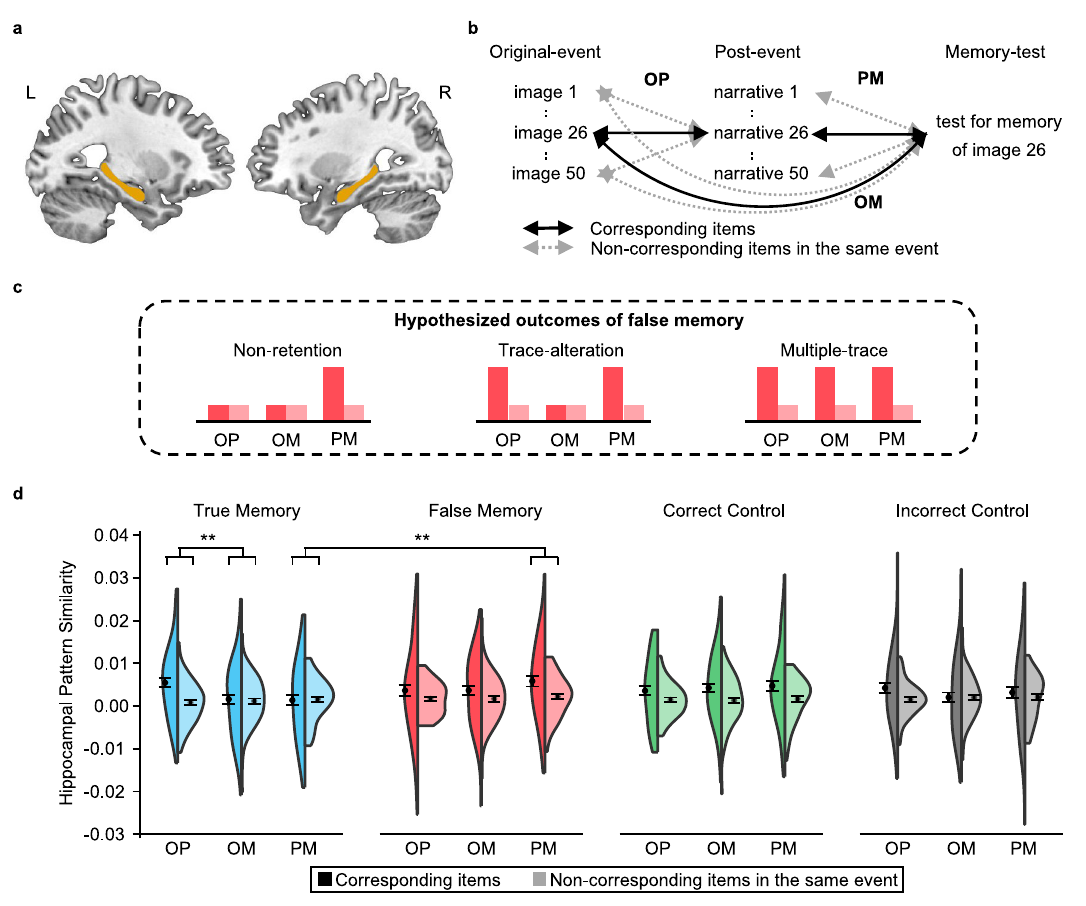
Fig. 3 | Hippocampal pattern similarity across three memory stages. a The hippocampus(yellow)ontheleft(L)andright(R)hemispheresofthebrain. b Three types of cross-stage similarity (i.e., OP [between original-event and post-event stages], OM [between original-event and memory-test stages], and PM [between post-event and memory-test stages]) for the corresponding items and for the non- correspondingitemsinthesameevent. c Hypothesizedoutcomesoffalsememory based on the three theories. d Hippocampal pattern similarity for the corre- spondingitemsandforthenon-correspondingitemsforthreedifferentstagepairs by memory type (true memory, false memory, correct control, and incorrect